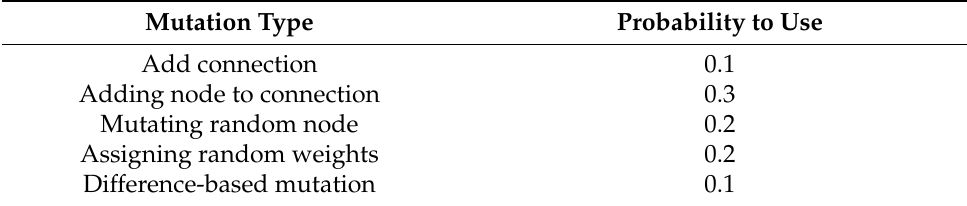
Table 1. Probabilities of mutation operators in